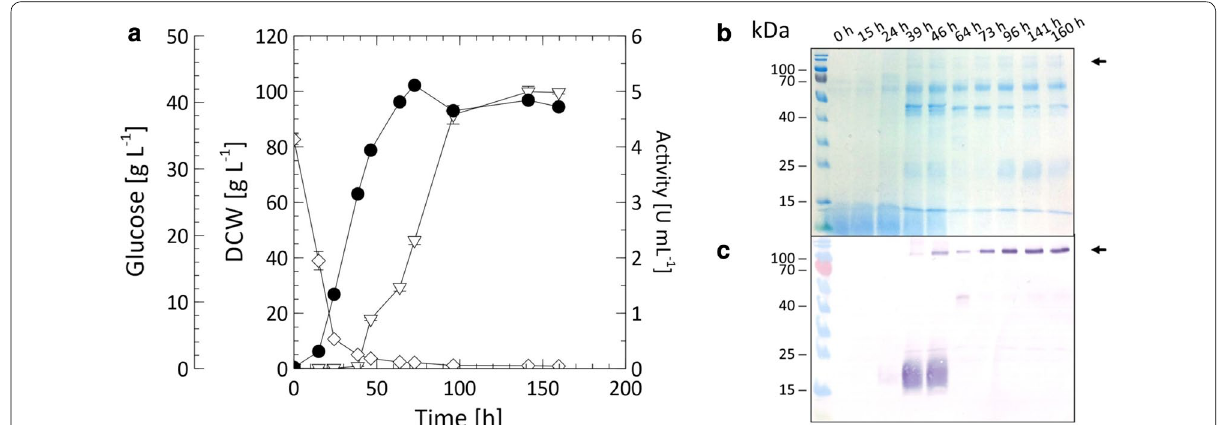
Fig. 6 a Time course of DCW (black circle), glucose concentration (white diamond), and laccase activity (white up-pointing triangle) during a representative fed-batch cultivation of A. adeninivorans G1212/YRC102-TEF1-TVLCC5-6H. Coomassie-stained SDS-PAGE ( b ) and western-blot analysis with anti-6 His antibody c show the accumulation of recombinant Tvlcc5 in the supernatant of samples taken at each time ×